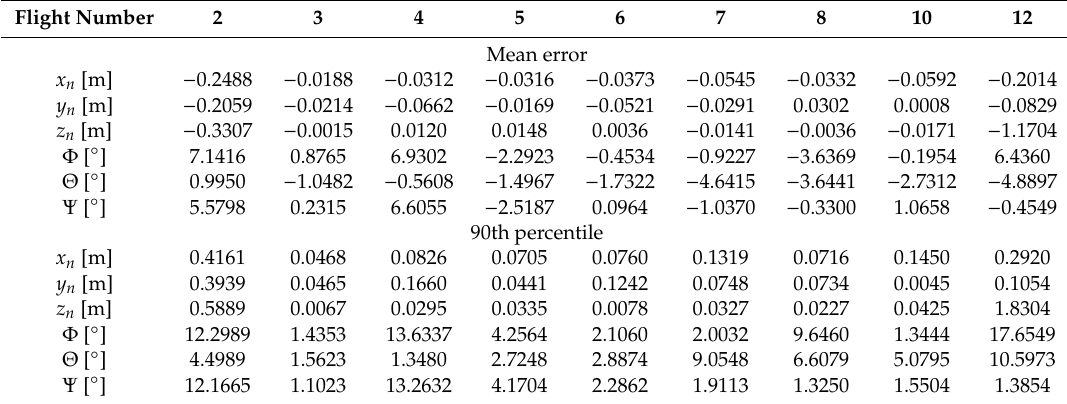
Table 6. Mean error and 90th percentile (from launch guide clearance to main motor ignition).